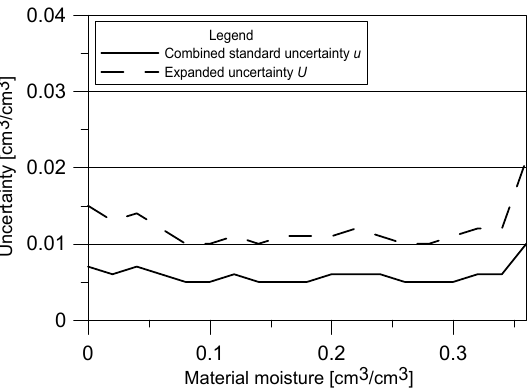
Figure 7. Combined standard and expanded measurements uncertainties of the TDR surface sensor for aerated concrete.